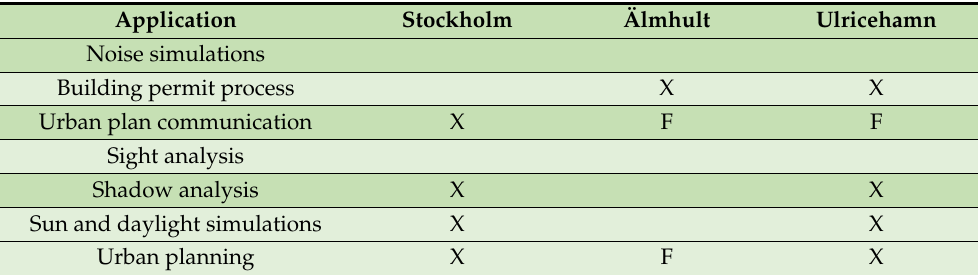
Table 2. Current applications (X) and planned future applications (F) of 3D city models in three Swedish